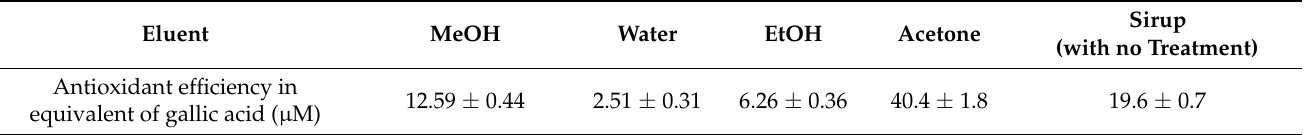
Figure 5. FTIR spectra of bird cherry extracts using hexane, methanol, ethanol, and water and measured directly from fruit. Table 3. Antioxidant efficiency of examined extracts with standard